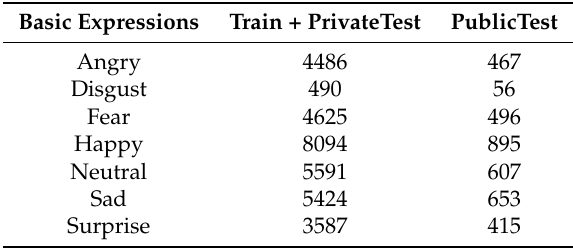
Table 1. The distribution of each category sample in